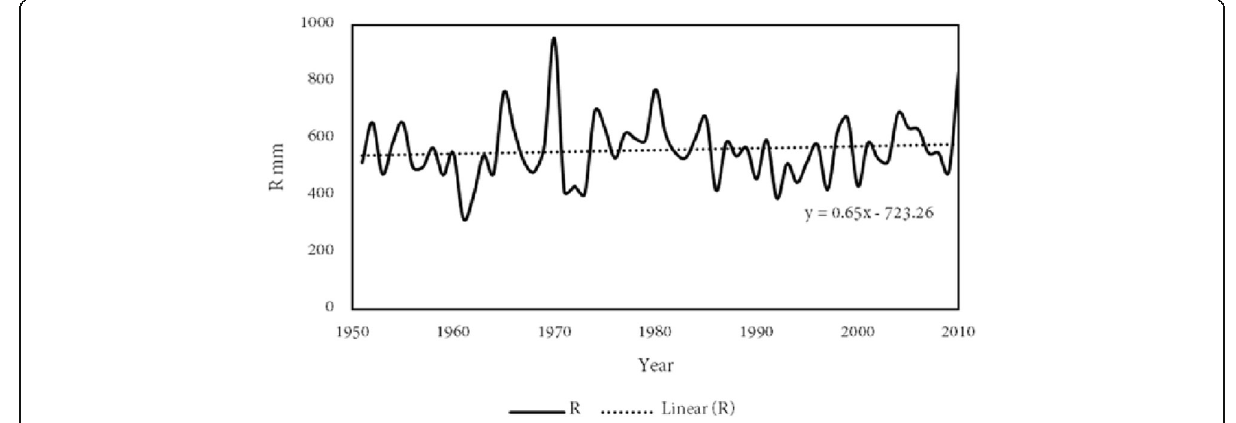
Fig. 2 Yearly rainfall changes in the studied area from 1950 to 2010